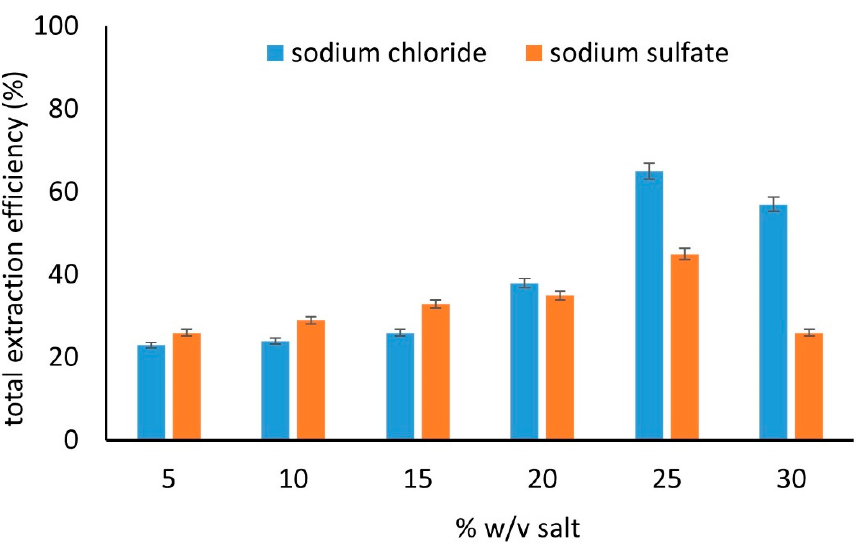
Figure 5. Total extraction efficiency of the examined compounds from solutions with different ionic strength using the GQDs-LDH composite material (number of replicate analyses = 3).